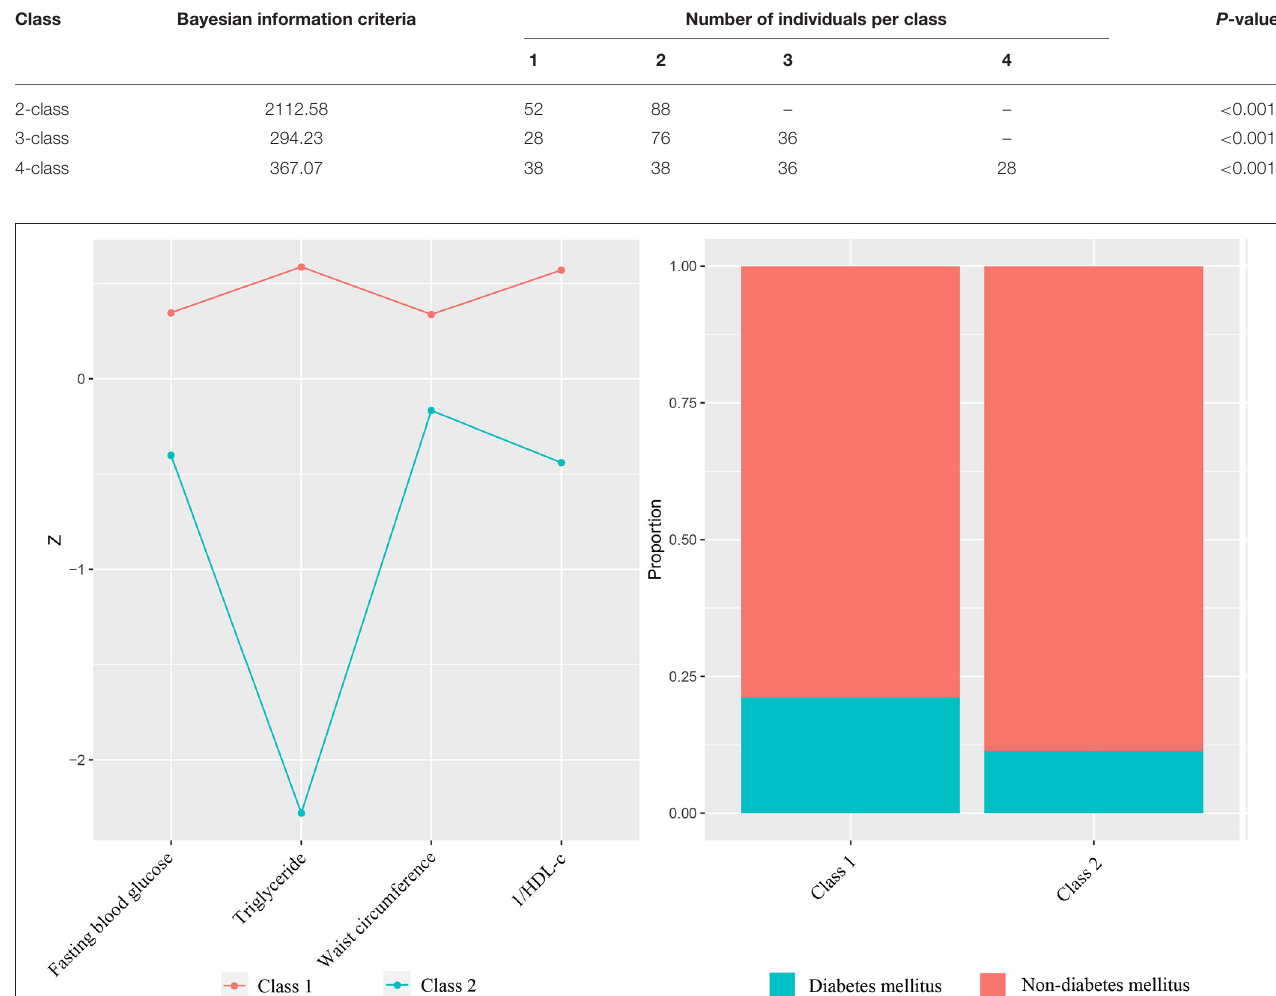
TABLE 1 | Summary of latent class model identification and fit statistics.